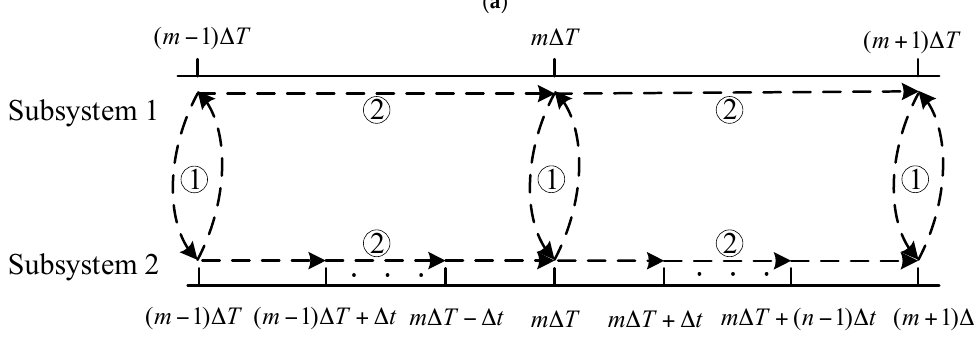
Figure 1. The simulation calculation timing. ( a ) The serial calculation timing. ( b ) The parallel calculation timing.